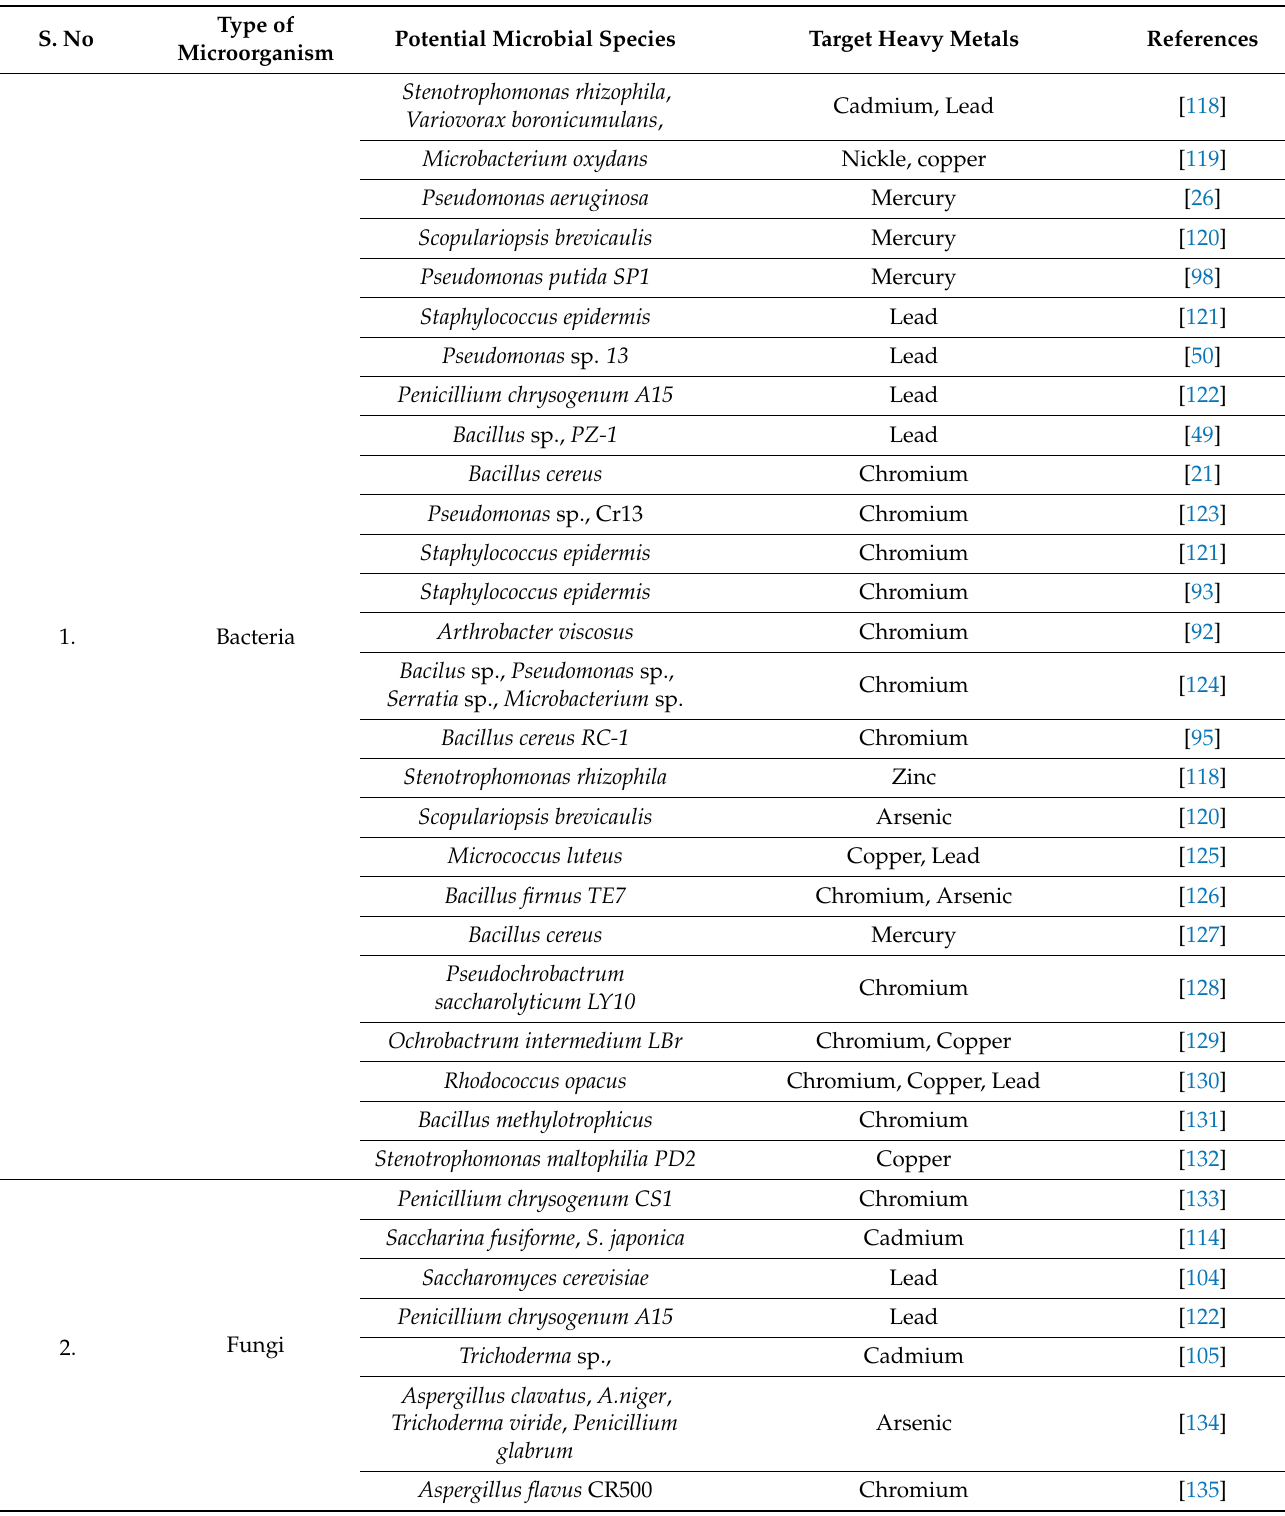
Table 1. Microbial remediation of heavy metal contaminated